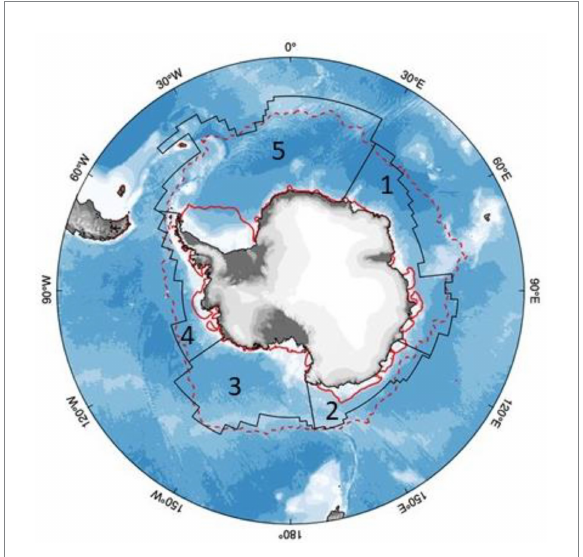
FIGURE 2 Map showing the five MEASO sectors, with average minimum (solid red line) and maximum (dotted red line) sea-ice extent highlighted. Sectors are numbered 1 (Central Indian), 2 (East Indian), 3 (West Pacific), 4 (East Pacific) and 5